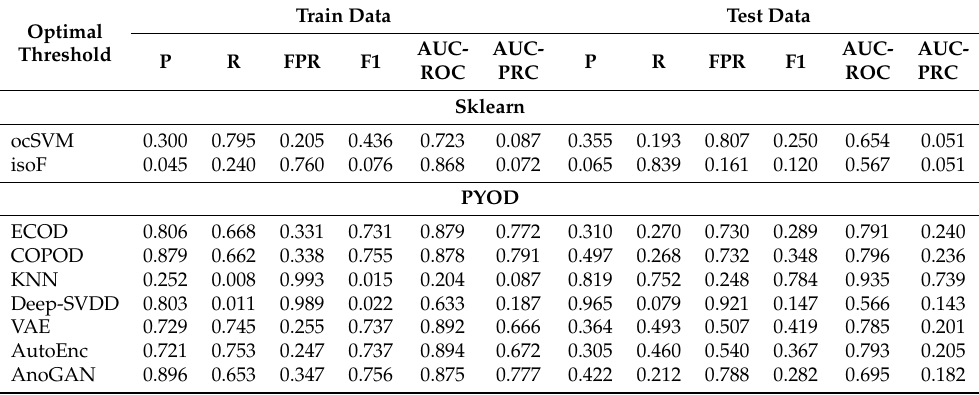
Table 4. The results of Experiment 1 for the time split mode for the SWaT